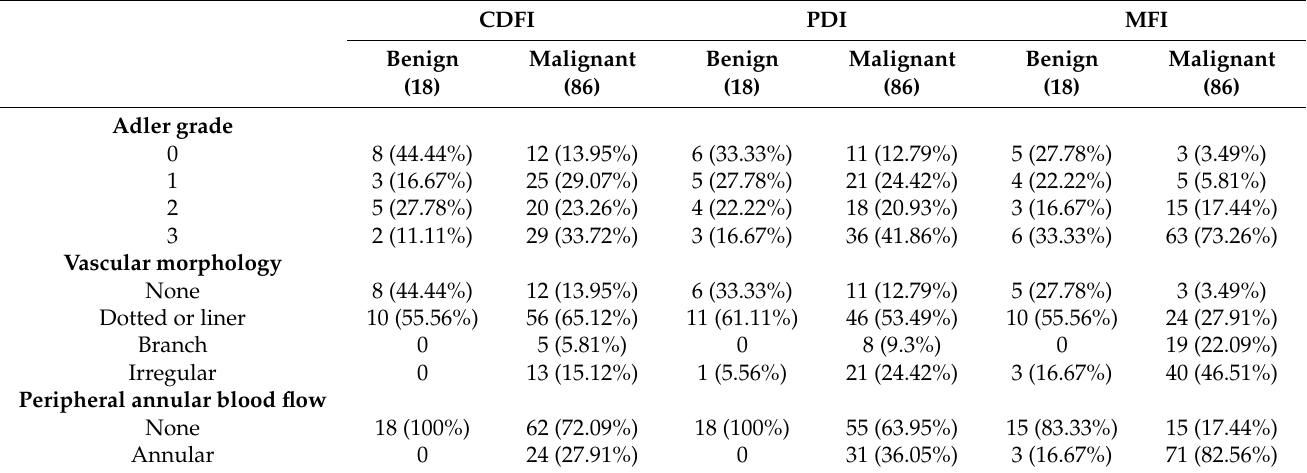
Table 3. Blood flow characteristics of renal benign and malignant tumors ≤ 4 cm evaluated by CDFI, PDI and MFI